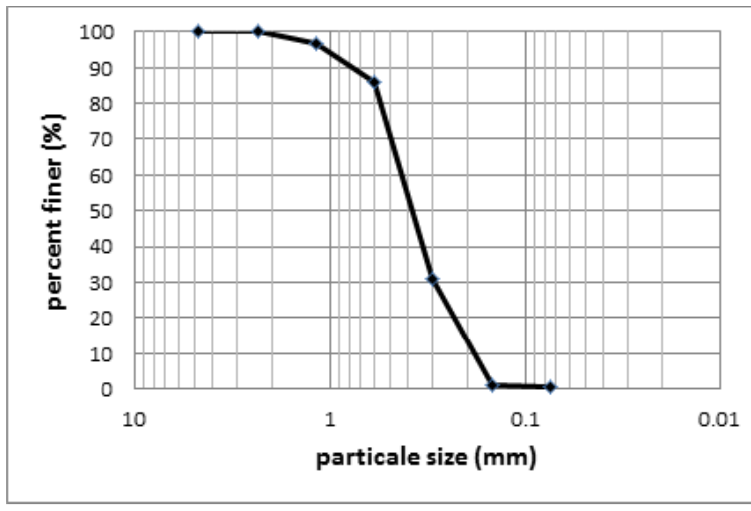
Fig. 2. Grain size distribution of the soil used.